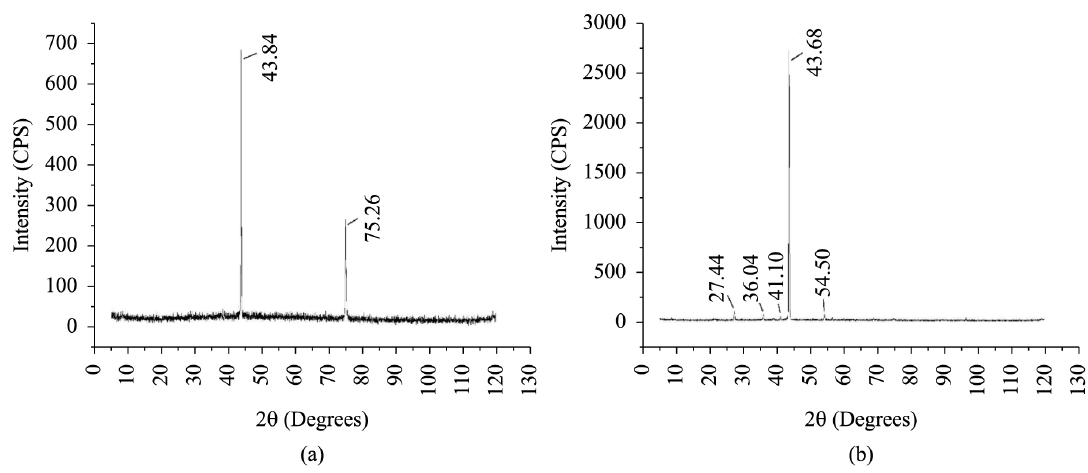
Figure 6. Diffractogram of (a) uncoated diamonds and (b) Ti-coated diamonds, after heat treatment during 60 min.